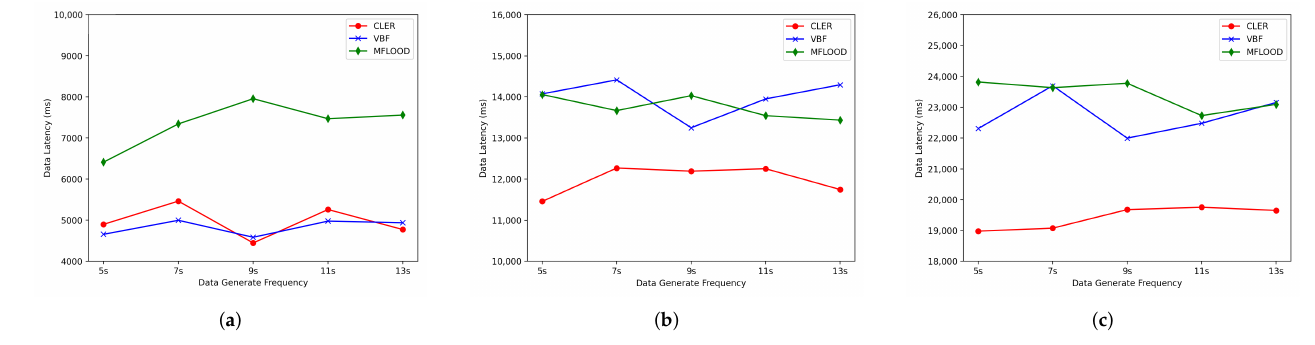
Figure 7. Test results of the Packet Latency. ( a ) Data Latency when need One hop. ( b ) Data Latency when need Two hop. ( c ) Data Latency when need Three hop.